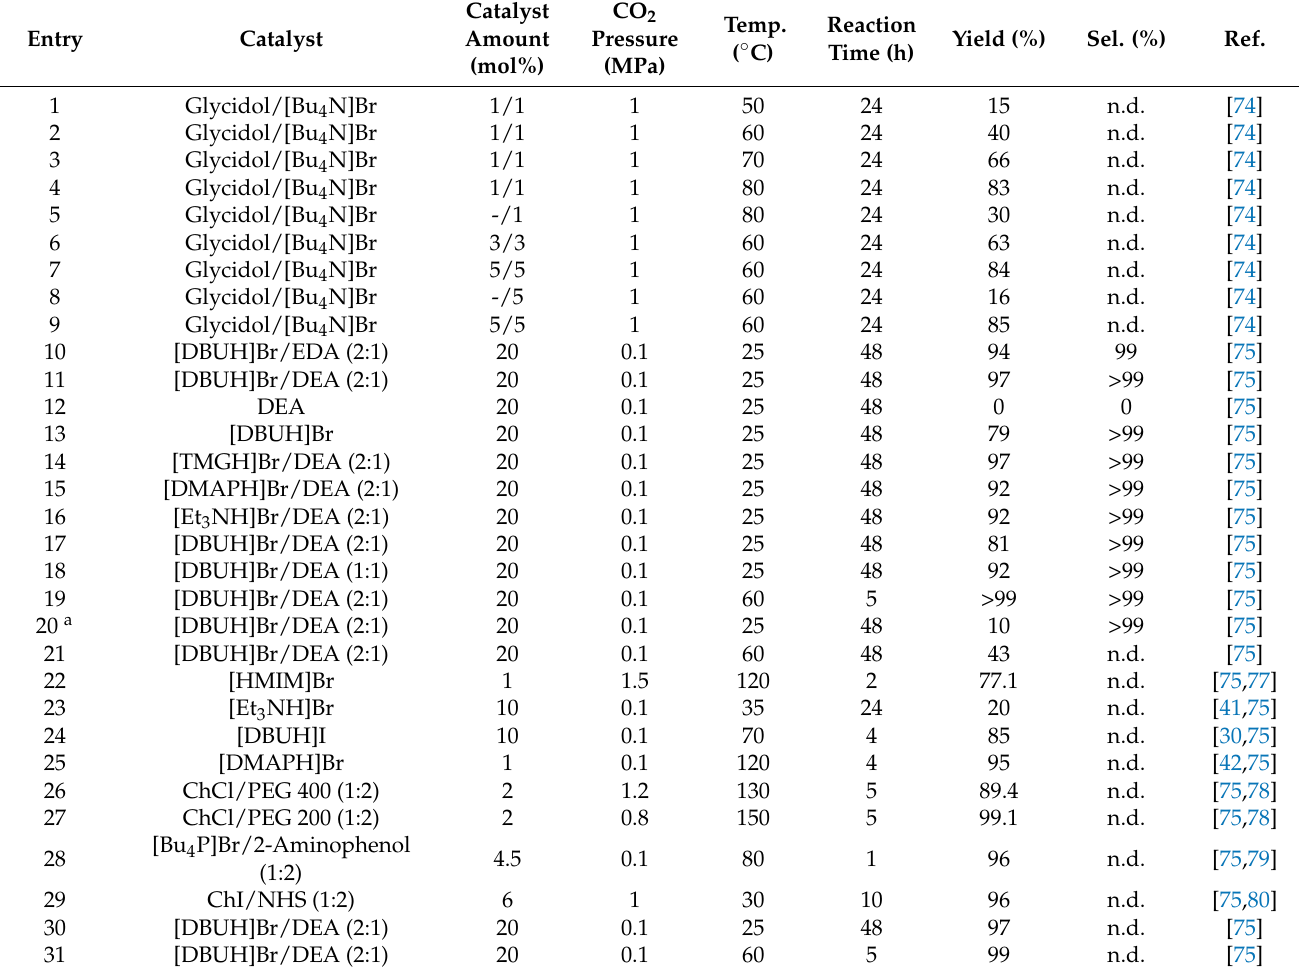
Table 18. Comparison of the catalytic activity of various PILs and DESs for the carbonation of